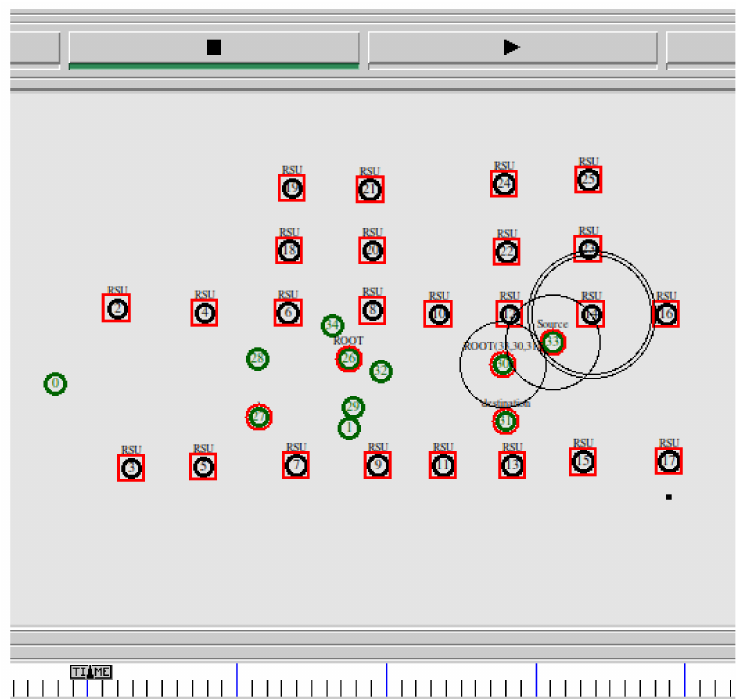
Figure 7. Source node multicast route request packets.